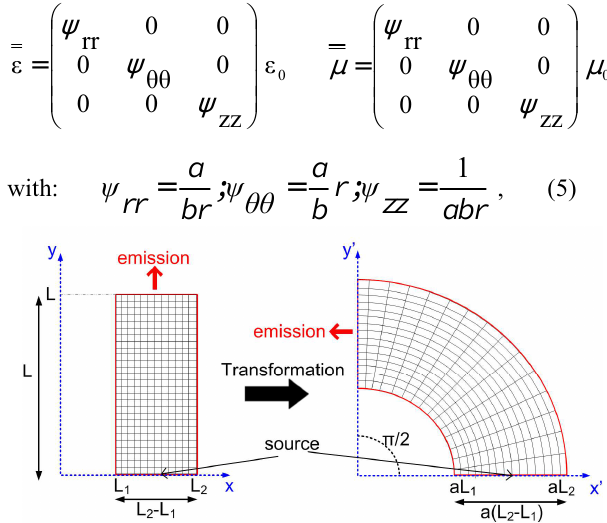
Figure 6: Schematic principle of the 2D rotational coordinate transformation. The emission in a rectangular space is transformed into an azimuthal one.